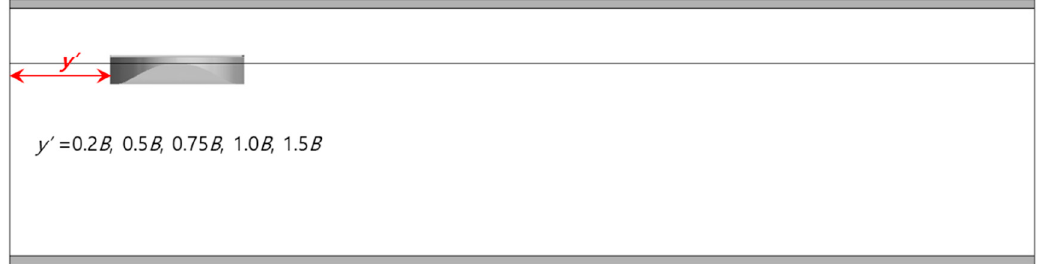
Figure 2. Calculation conditions for barge–bank distance, y ′ .